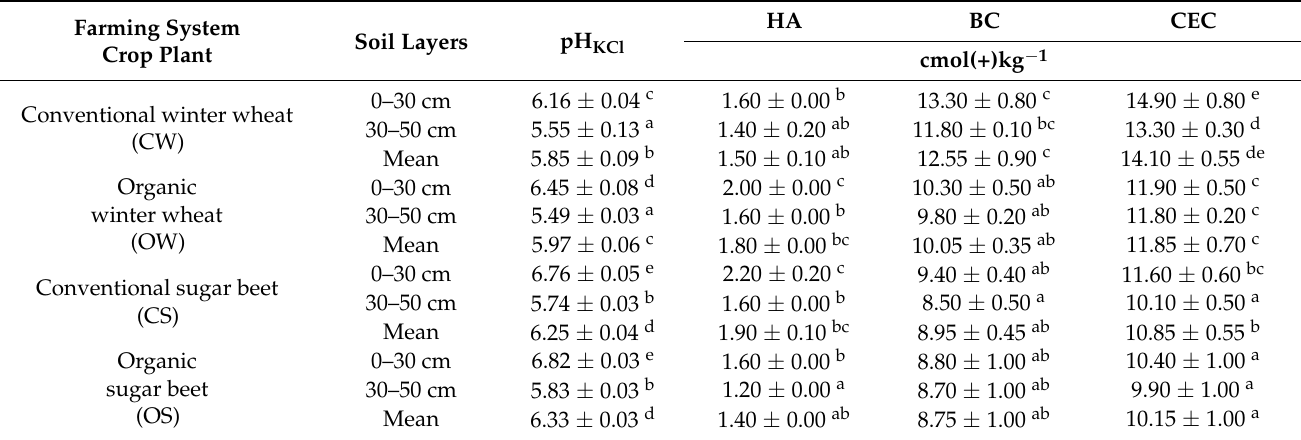
Table 5. Effect of the interaction of the experimental factors on the pH KCl and sorption properties of